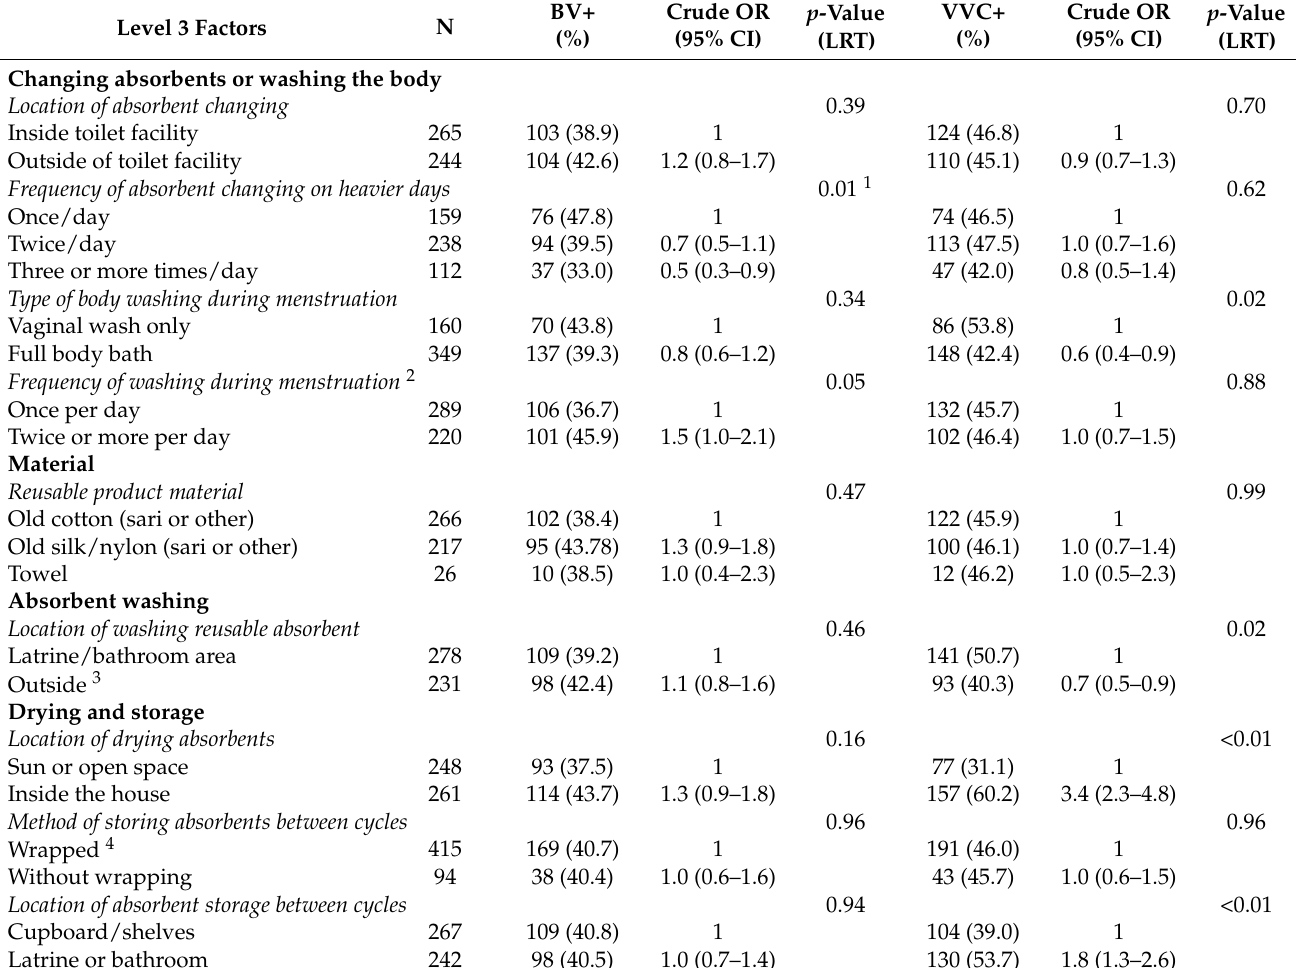
Table 3. Odds ratios for BV and VVC according to MHM practices (N =